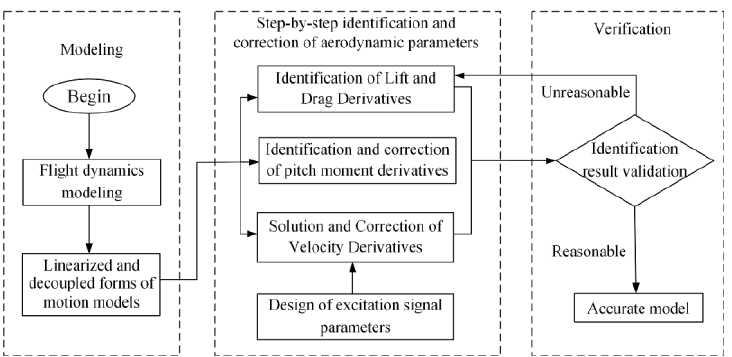
Figure 4. Aerodynamic parameter identification and correction steps based on the wind tunnel vir- tual flight.